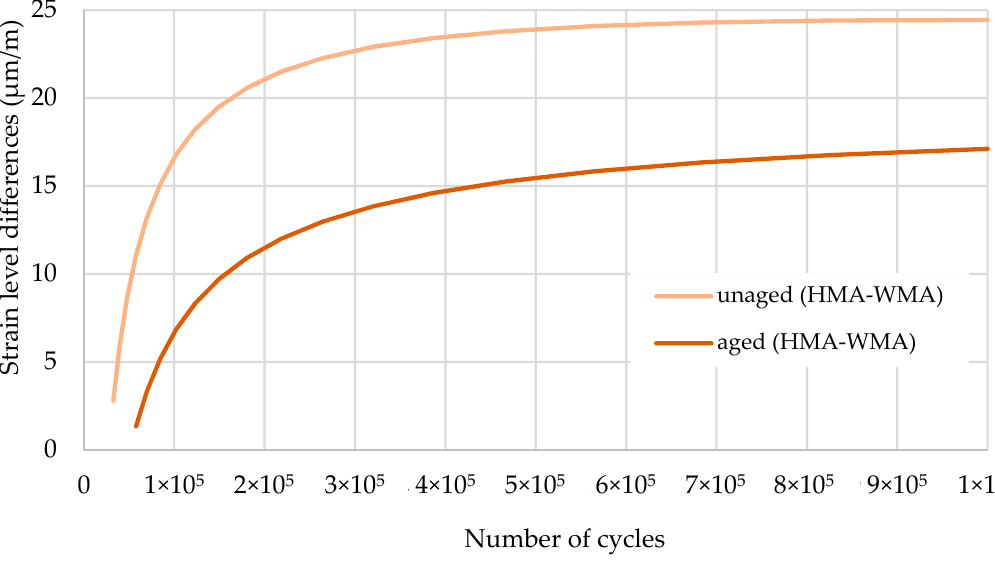
Figure 13. Comparison between HMA and WMA considering aged condition.